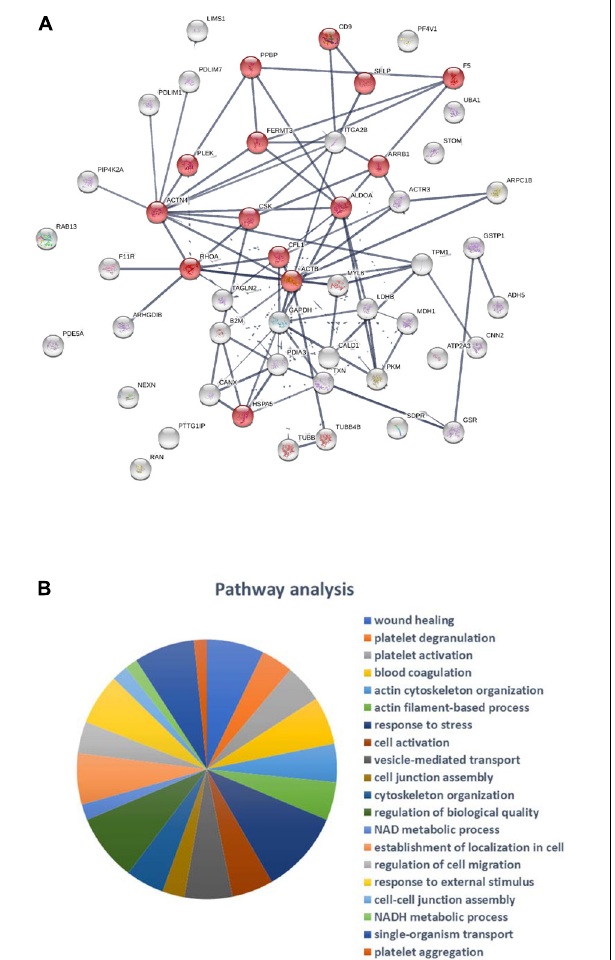
FIGURE 5 | (A) STRING network representation of the 47 platelet-derived MP proteins significantly modulated between non-obese and obese individuals: network nodes represent proteins; network edges indicate the strength of data support; significantly modulated proteins associated with “Platelet activation” pathway are highlighted in red. (B) The 20 top-ranked categories (false discovery rate) of KEGG pathways significantly enriched in our dataset.